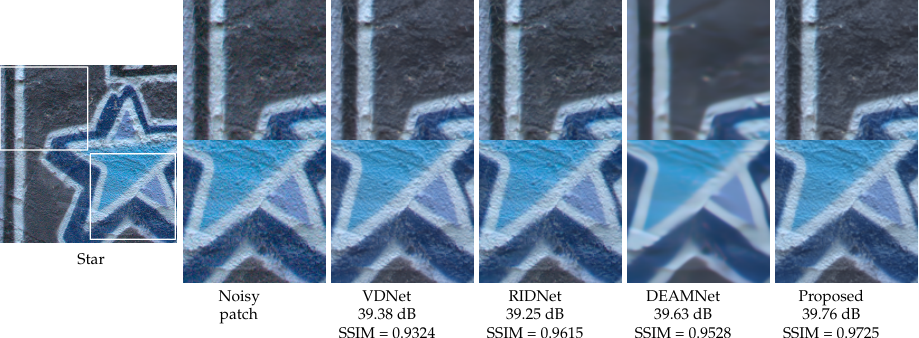
Figure 12. Visual quality comparison with PSNR and SSIM scores for “Star” from the DnD dataset with real noises (for best view, zooming in is